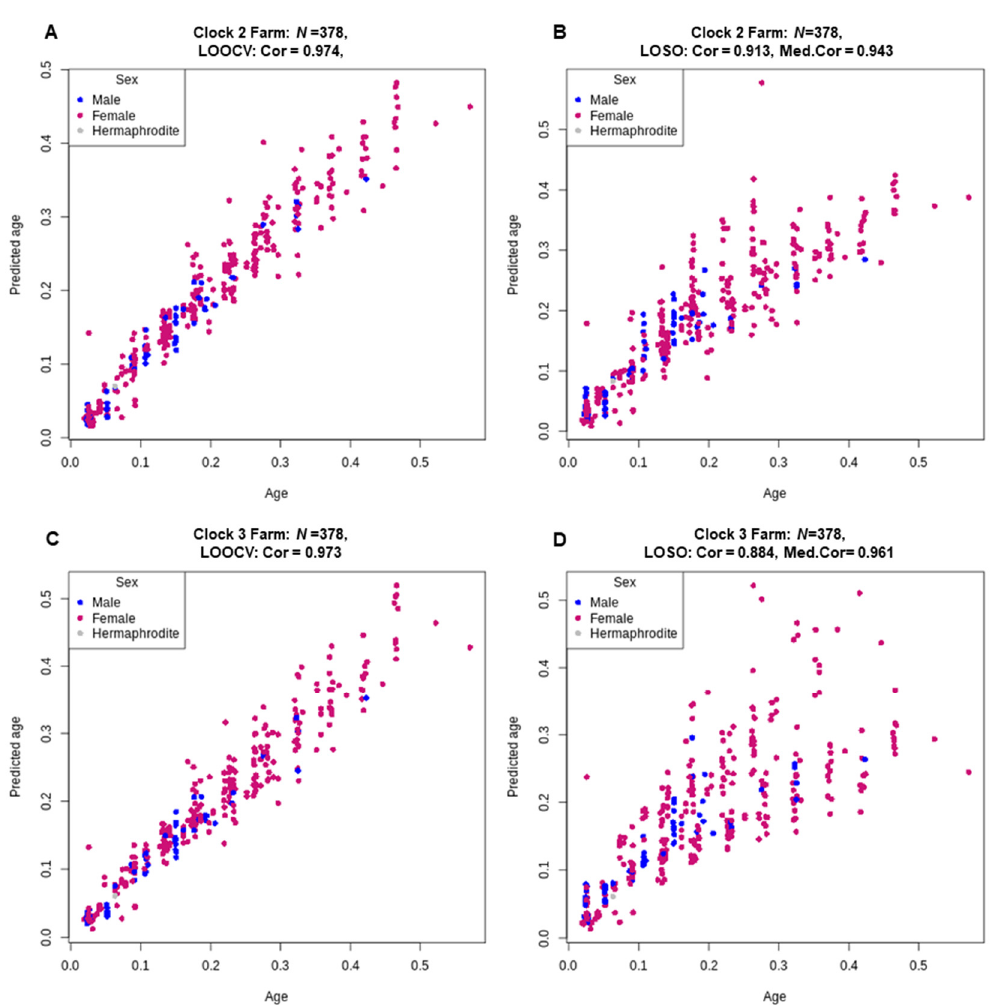
Figure 3. Relative age (x-axis) versus back-transformed relative epigenetic age estimated for Farm clock 2 (loglogRelativeAge; ( A , B )) and Farm clock 3 (log-linear transformed age; ( C , D )). Age estimates were predicted via both LOOCV ( A , C ) and LOSO ( B , D ) cross-validation. The Pearson correlation coefficients (Cor) are reported for the age estimates using both LOOCV and LOSO cross-validation and the median correlation coefficients (Med.Cor) for each fold of the LOSO cross-validation are reported.